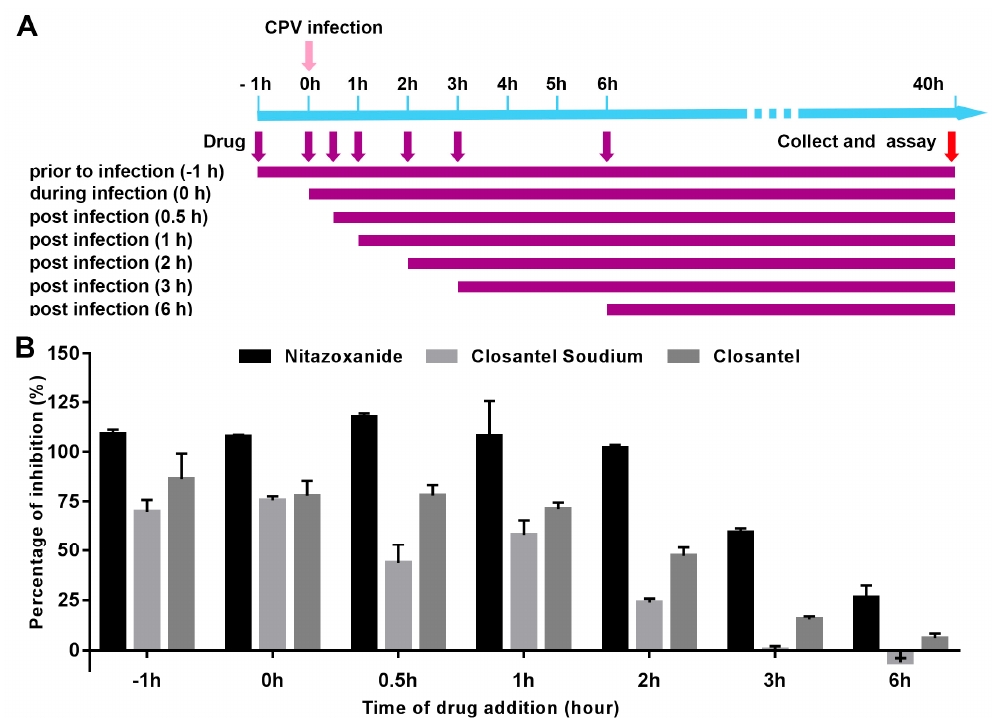
Figure 5. Time of addition analysis of the antiviral effects of identified drugs. ( A ) Timeline of time of addition assay. F81 cells were inoculated with CPV and treated with 10 μ M Nitazoxanide, Closantel Sodium, and Closantel, respectively, at different time points, designated prior to infection ( − 1 h), during infection (0 h), postinfection (0.5 h, 1 h, 2 h, 3 h, or 6 h). Antiviral effects were determined according to the percentage CPE inhibition. ( B ) Percentage CPE inhibition of Nitazoxanide, Closantel Sodium, and Closantel added at different time points, presented in bar graphs. Error bars represent standard errors from three independent experiments.